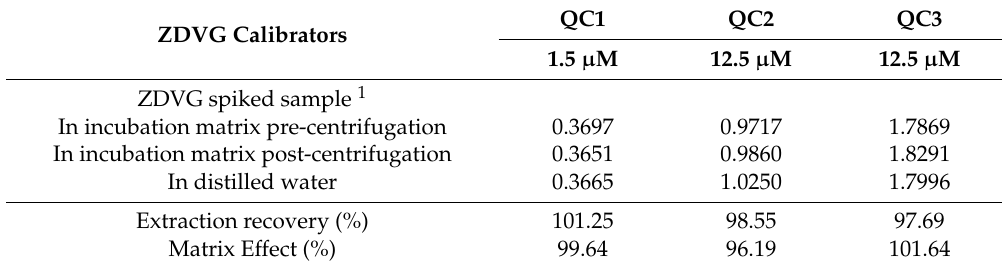
Table 3. Extraction recovery and matrix effect of zidovudine glucuronides (ZDVG). Measurement was made from five independent experiments ( n =